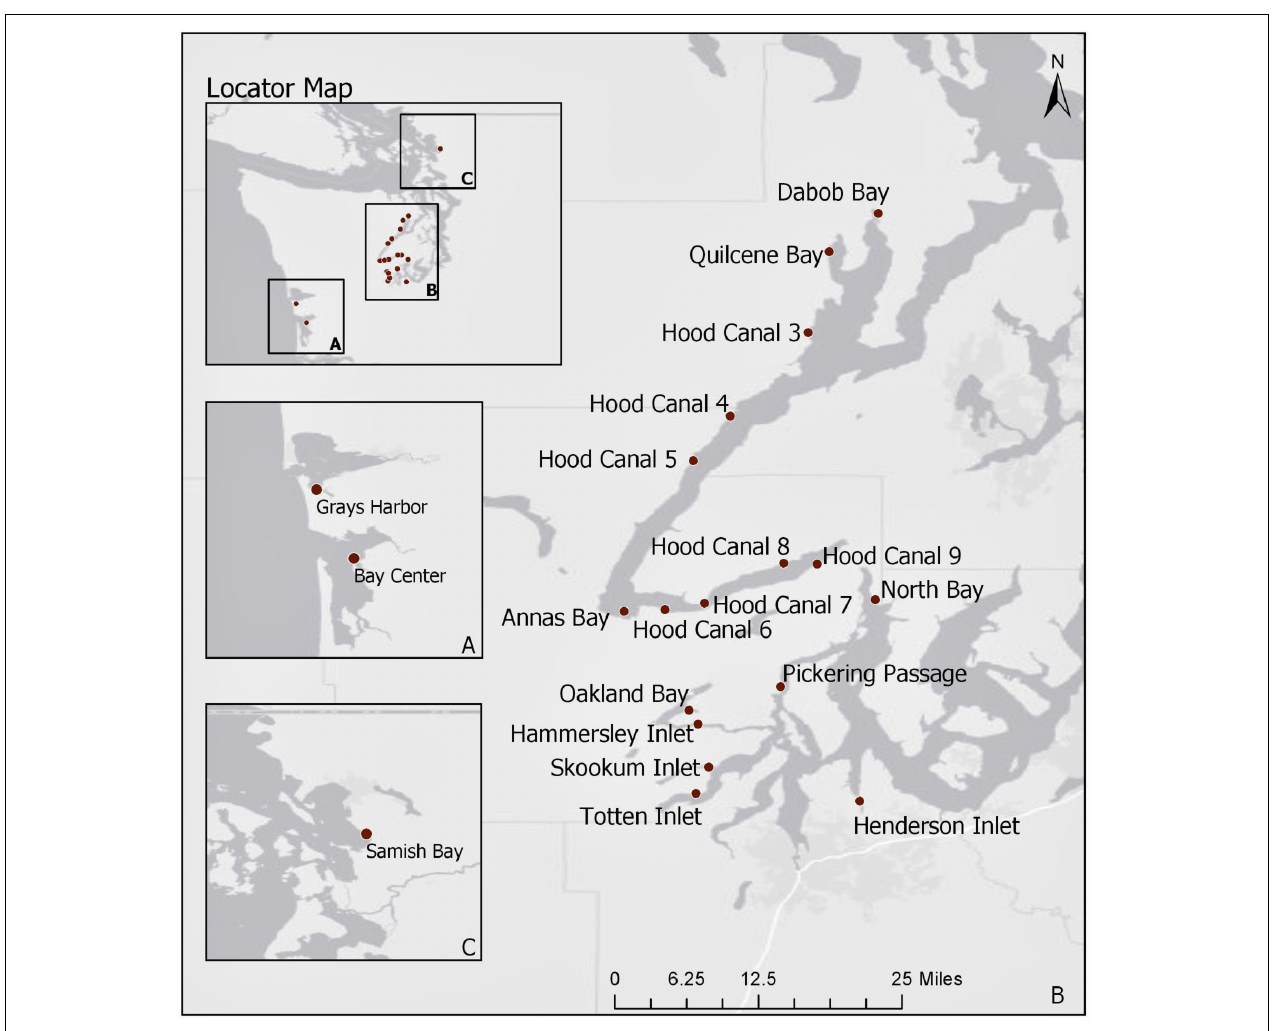
FIGURE 1 | Map of Washington State shellfish sampling sites between 2014 and 2018. Panel A displays the coastal bays, panel B (main map) includes South Puget Sound and Hood Canal, and panel C displays Samish Bay in the northern waters. Basemap attributed to ESRI